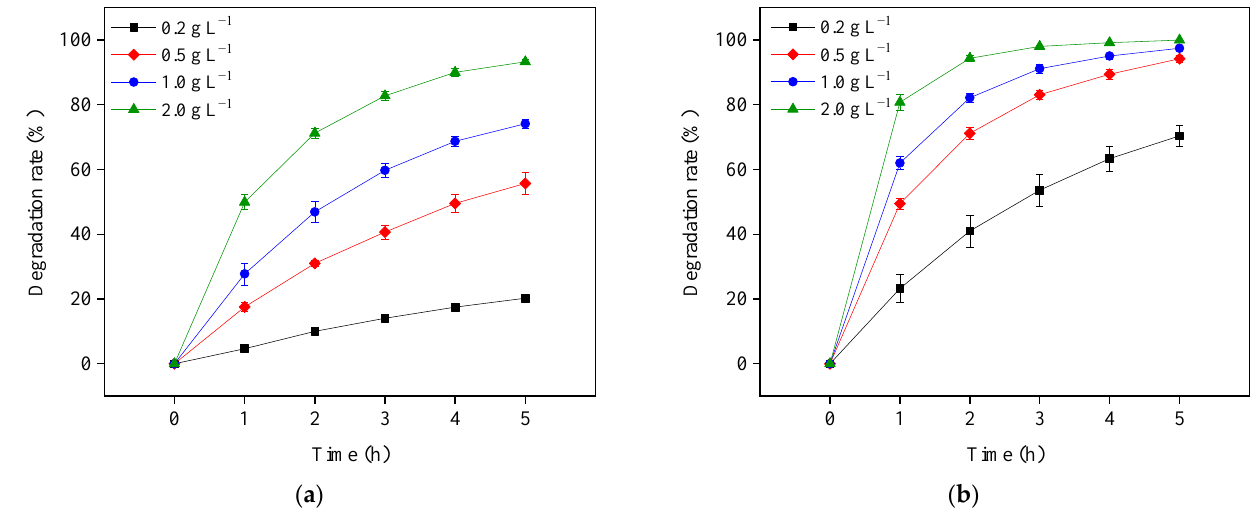
Figure 6. TiO 2 load effects on OTC degradation in the visible light/TiO 2 system at pH 5.7 ( a ) and 8.6 ( b ). Experimental conditions: [OTC] 0 = 10 mg L −1 , 50 mM phosphate buffer.